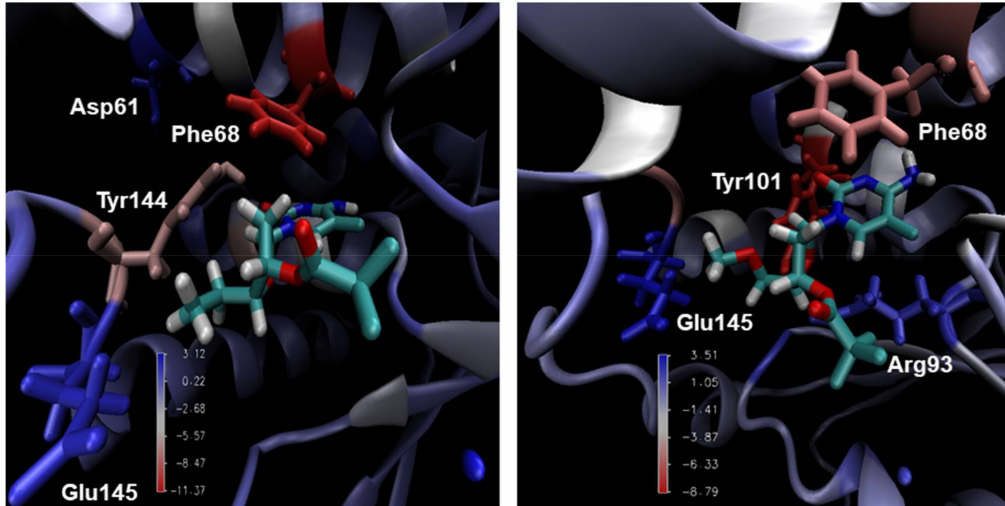
Figure 6. Main interactions of the complexes Var TMPK/compound 3 ( left ) and Var TMPK/compound 6 ( right ) calculated by